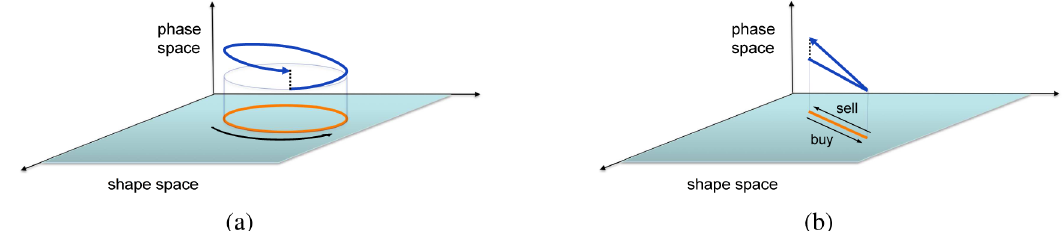
Fig 1. Geometric phase in continuous and discrete time. Panel (a): classical picture for geometric phase of a continuous-time dynamical system: a cyclic path in shape space (orange curve) induces a net motion on the phase variable (blue curve), proportional to the area of the cycle in shape space, see Supplementary Notes for an explicit model. Panel (b): geometric phase for a discrete-time dynamical system. A cyclic trajectory, even of zero-area in shape space (orange), induces a net nonzero motion in the phase variable (blue). In the stock trading application, the shape variables are the amount of stocks owned by a trader and the stock quote. The phase variable is the cash balance of the trader.